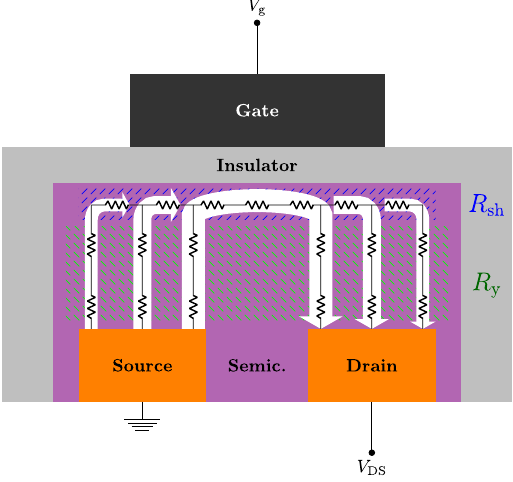
Figure 6. Sketch of the cross–section of the OTFT under current